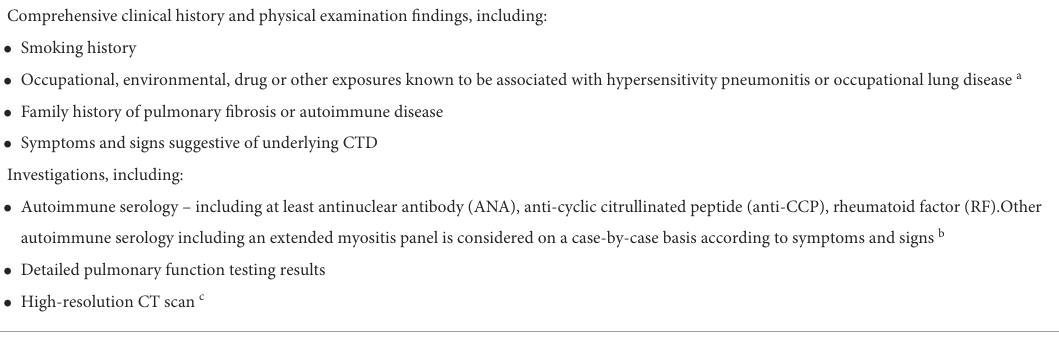
TABLE 1 Key data inputs and outputs for each case discussed at the ILD MDM, based on international expert consensus guidelines. Core data to be presented for each